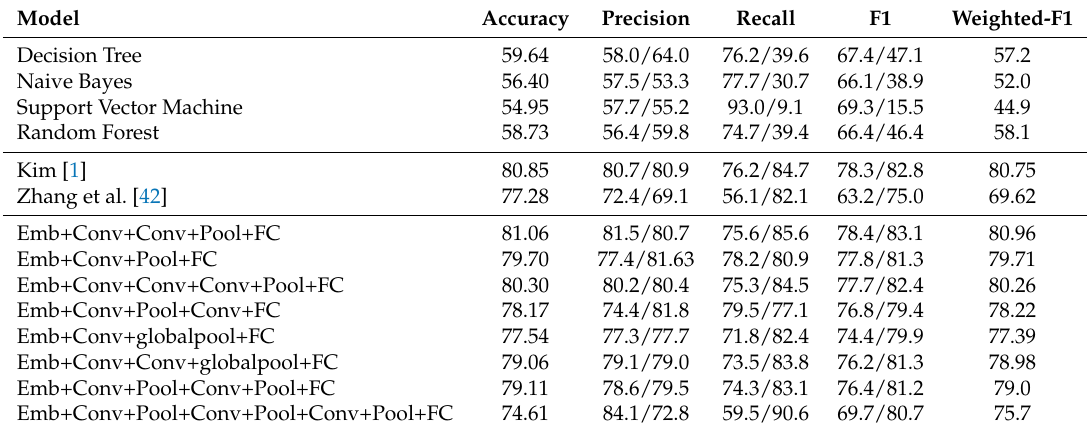
Table 3. The results with the MR data, where Emb, Conv, Pool, globalpool, FC stand for embedding layer, convolutional layer, pooling layer, global pooling layer, and fully-connected layer, respectively.